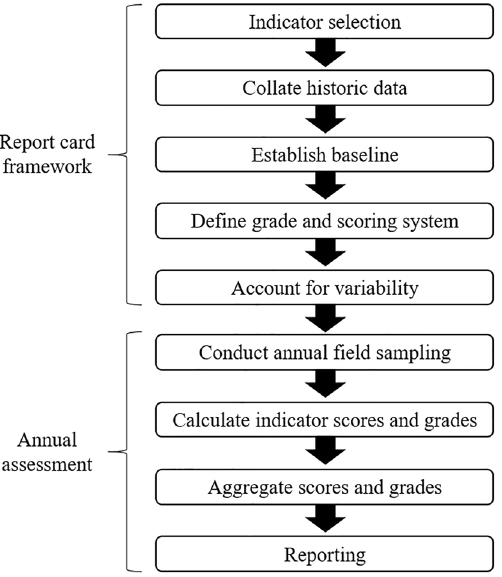
Figure 1. Flow chart to develop Gladstone Harbour seagrass grades and